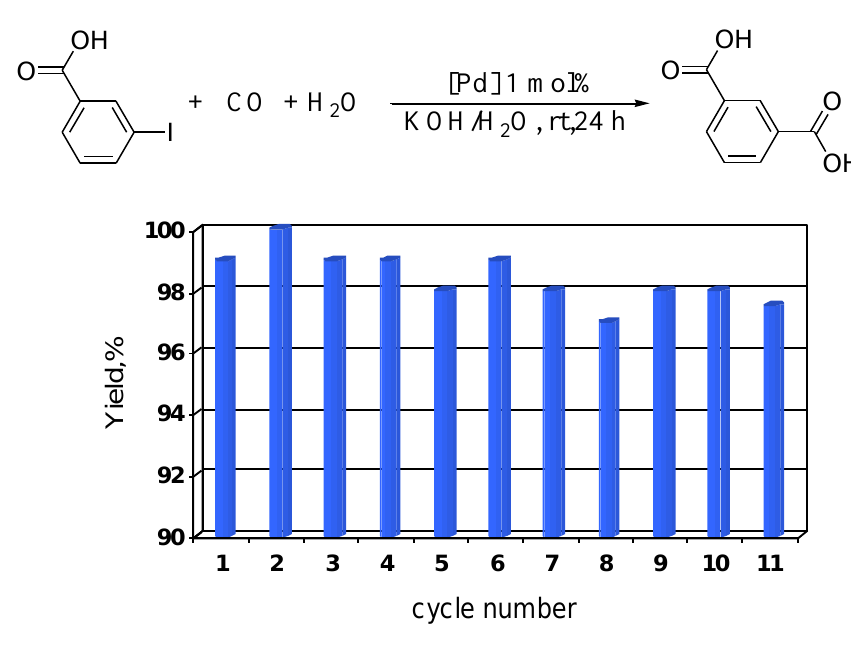
Figure 7. Hydroxycarbonylation of 3-iodobenzoic